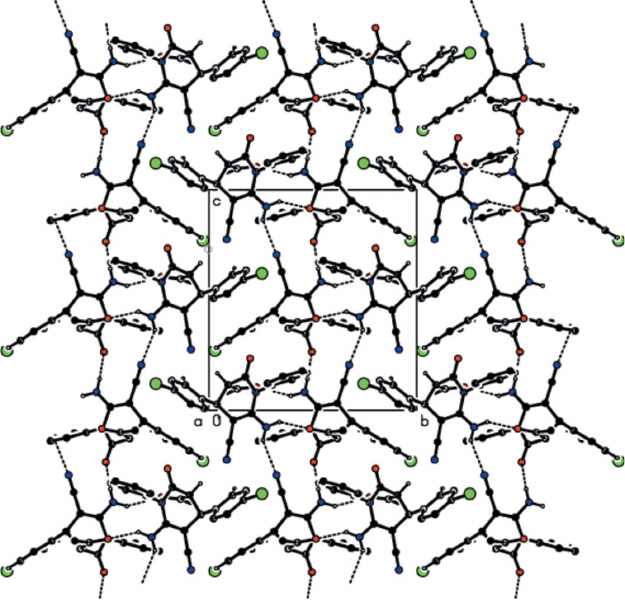
Figure 3 The crystal packing of the title compound viewed down the a axis, showing chains running along the c- axis direction formed through N— H (cid:2)(cid:2)(cid:2) O and N—H (cid:2)(cid:2)(cid:2) N hydrogen bonds.